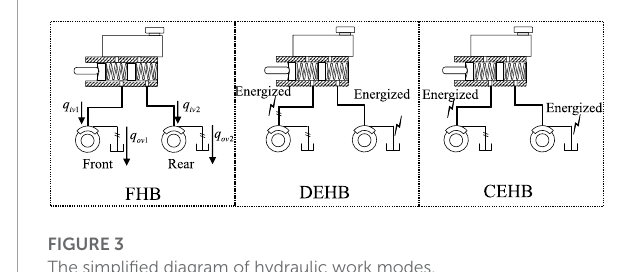
FIGURE 3 The simplified diagram of hydraulic work modes.